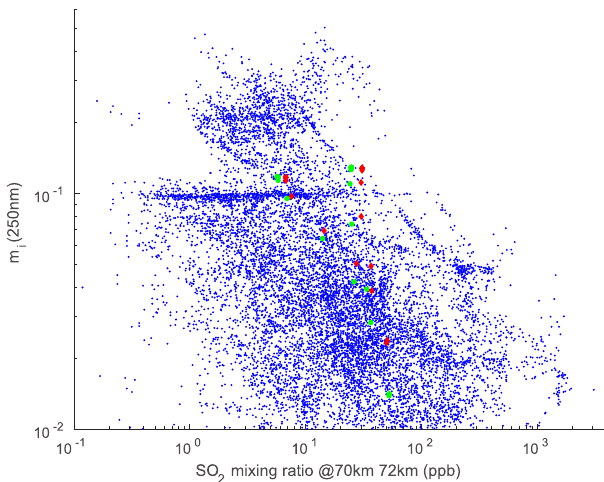
Fig. 3 Correlation between S x and SO 2 . Scatterplot showing imaginary index of refraction at 250 nm versus SO 2 at 70 km from Venus Express 10 (blue dots) compared to the scatterplot of S x versus SO 2 at 70 km (red diamonds) and 72 km (green dots) obtained from our model. The mixing ratios of S x in our model are multiplied by 2 × 10 5 in order to compare with the imaginary index of refraction derived from ref. 10